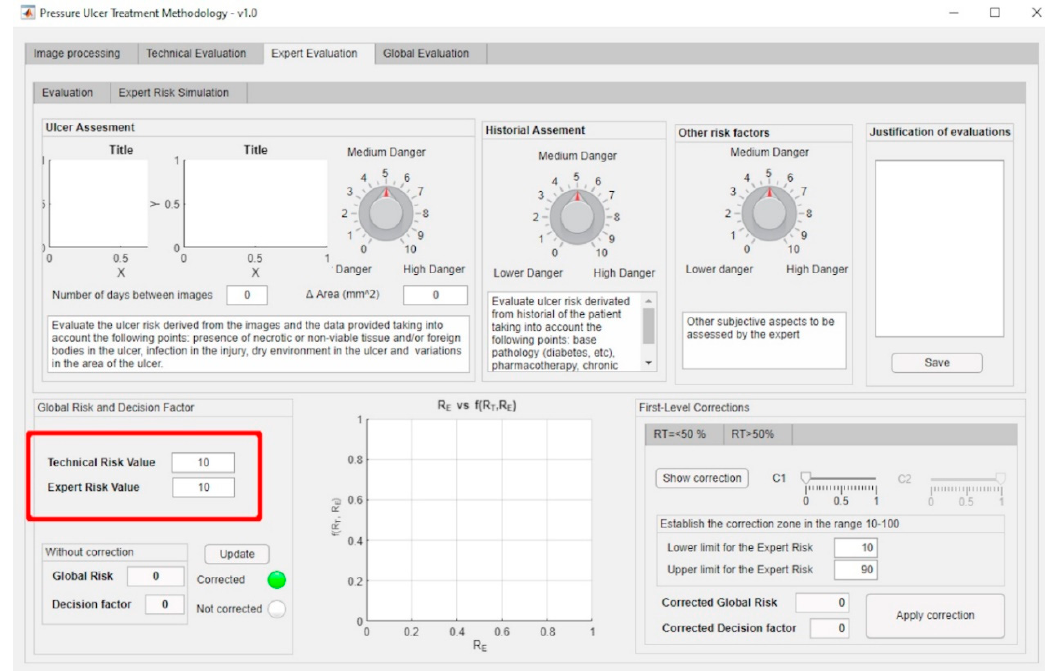
Figure 8. Expert Risk management panel.